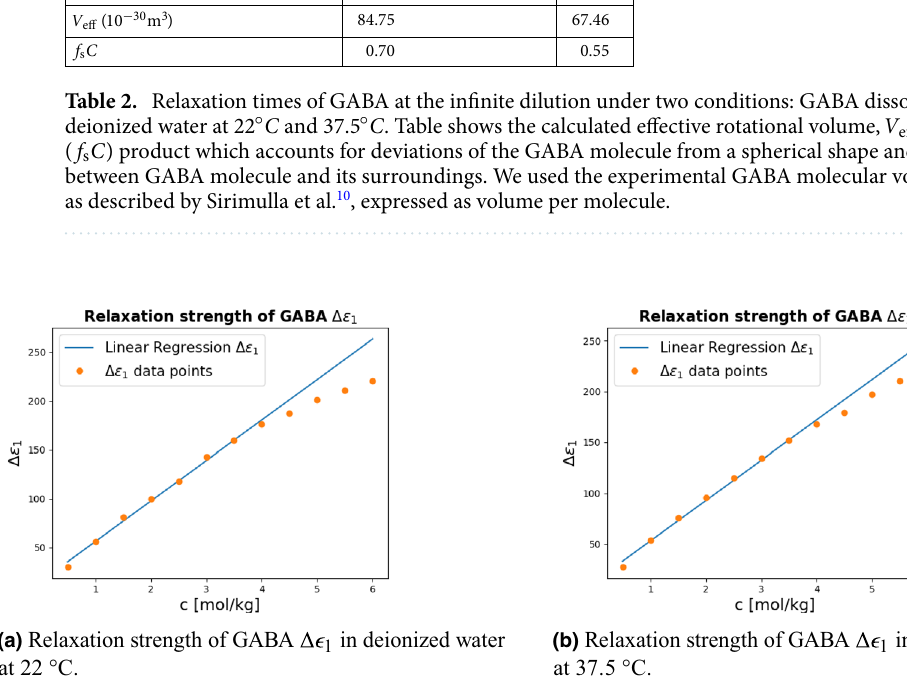
Figure 3. Relaxation strength �ǫ 1 of GABA molecules as a function of GABA molal concentration c at 22 ◦ C and 37.5 ◦ C . Solid lines correspond to linear regressions obtained by considering only the lower concentration data points, c ≤ 4.0